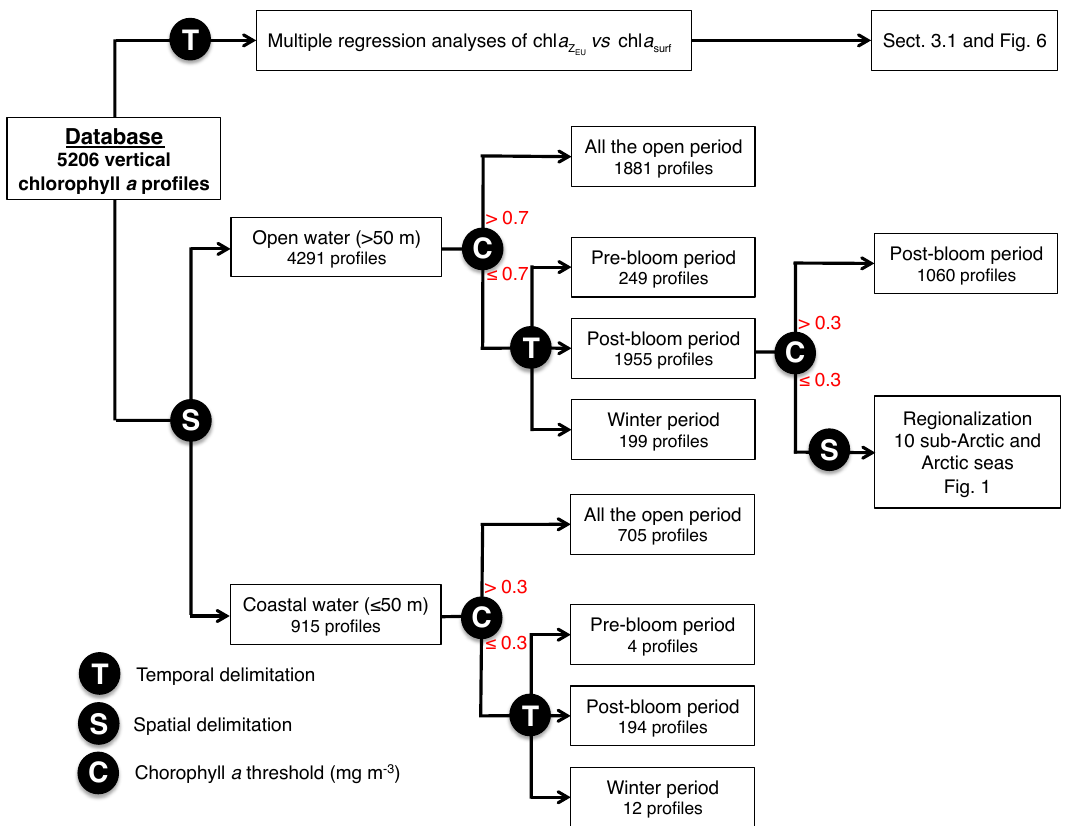
Fig. 3. A flowchart showing the partition and the use of the database (after quality control) for establishing the empirical model.